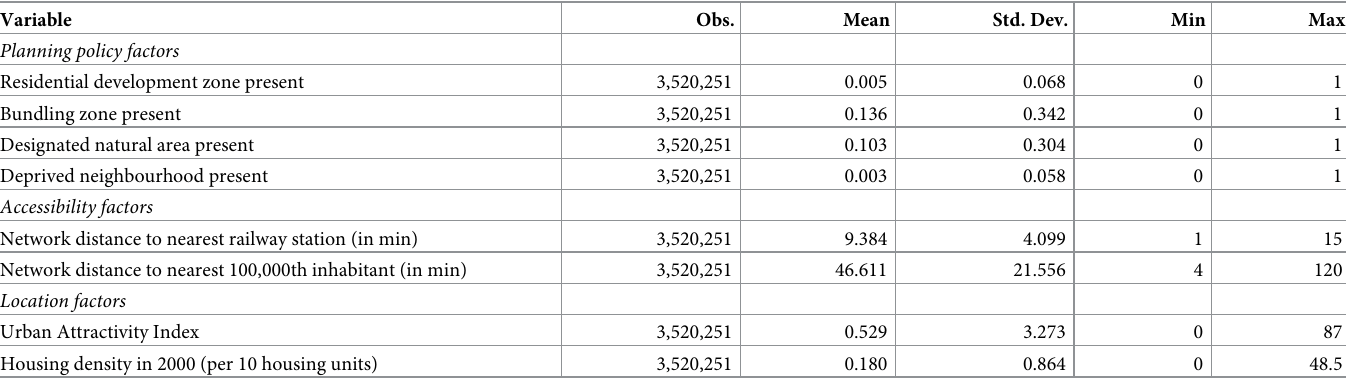
Table 1. Descriptive statistics for cells with urban residential